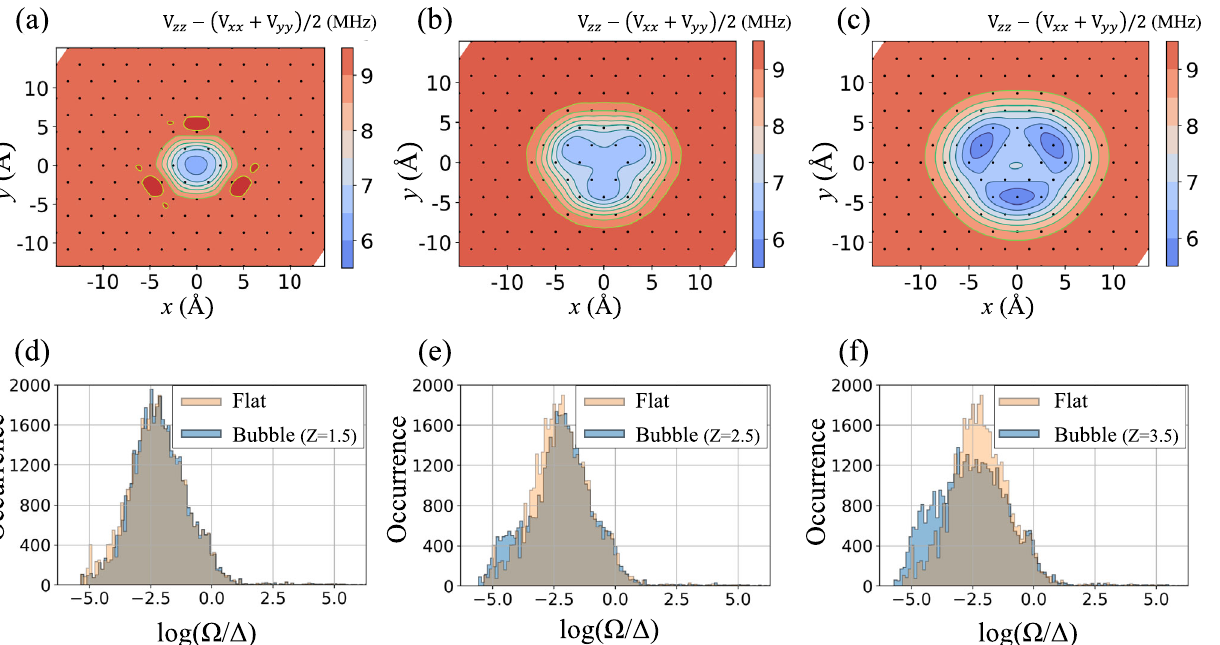
Fig. 5 Inhomogeneous nuclear quadrupole interaction of 10 B, induced by an inhomogeneous strain. a – c Spatial map of the coef fi cient of fi rst-order energy shift of the nuclear spins in curved h-BN, due to the quadrupole interaction, which is de fi ned as ζ = V Gaussian deformation is applied around the V B − , and the structures used for ( a ), ( b ), and ( c ) are the same as those shown in Fig. 4a, characterized by a Z = 1.5 Å and FWHW = 4 Å, b Z = 2.5 Å and FWHW = 8 Å, and c Z = 3.5 Å and FWHW = 10 Å. e , f Histogram of log( Ω / Δ ) of all the possible pseudospins in h-BN with Gaussian lattice deformation, where Ω is the fl ip- fl op transition rate, and Δ is the energy gap of a pseudospin (see Supplementary Note 4). The h-BN structures used are characterized by d Z = 3.5 Å and FWHW = 10 Å, e Z = 1.5 Å and FWHW = 4 Å, and f Z = 2.5 Å and FWHW = 8 Å, which are schematically shown in Fig.